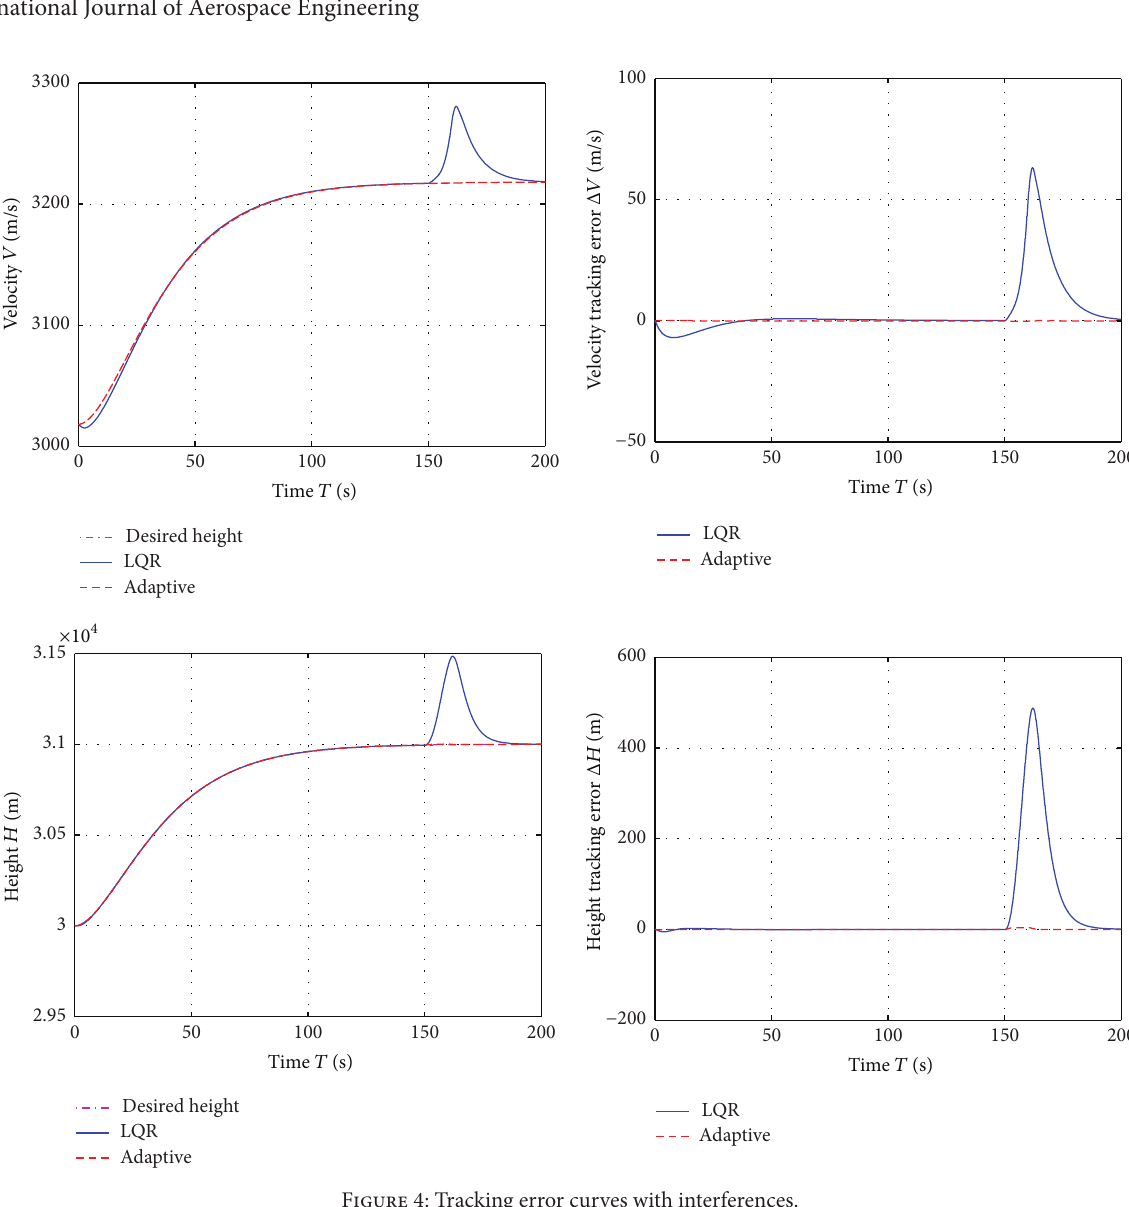
Figure 4: Tracking error curves with